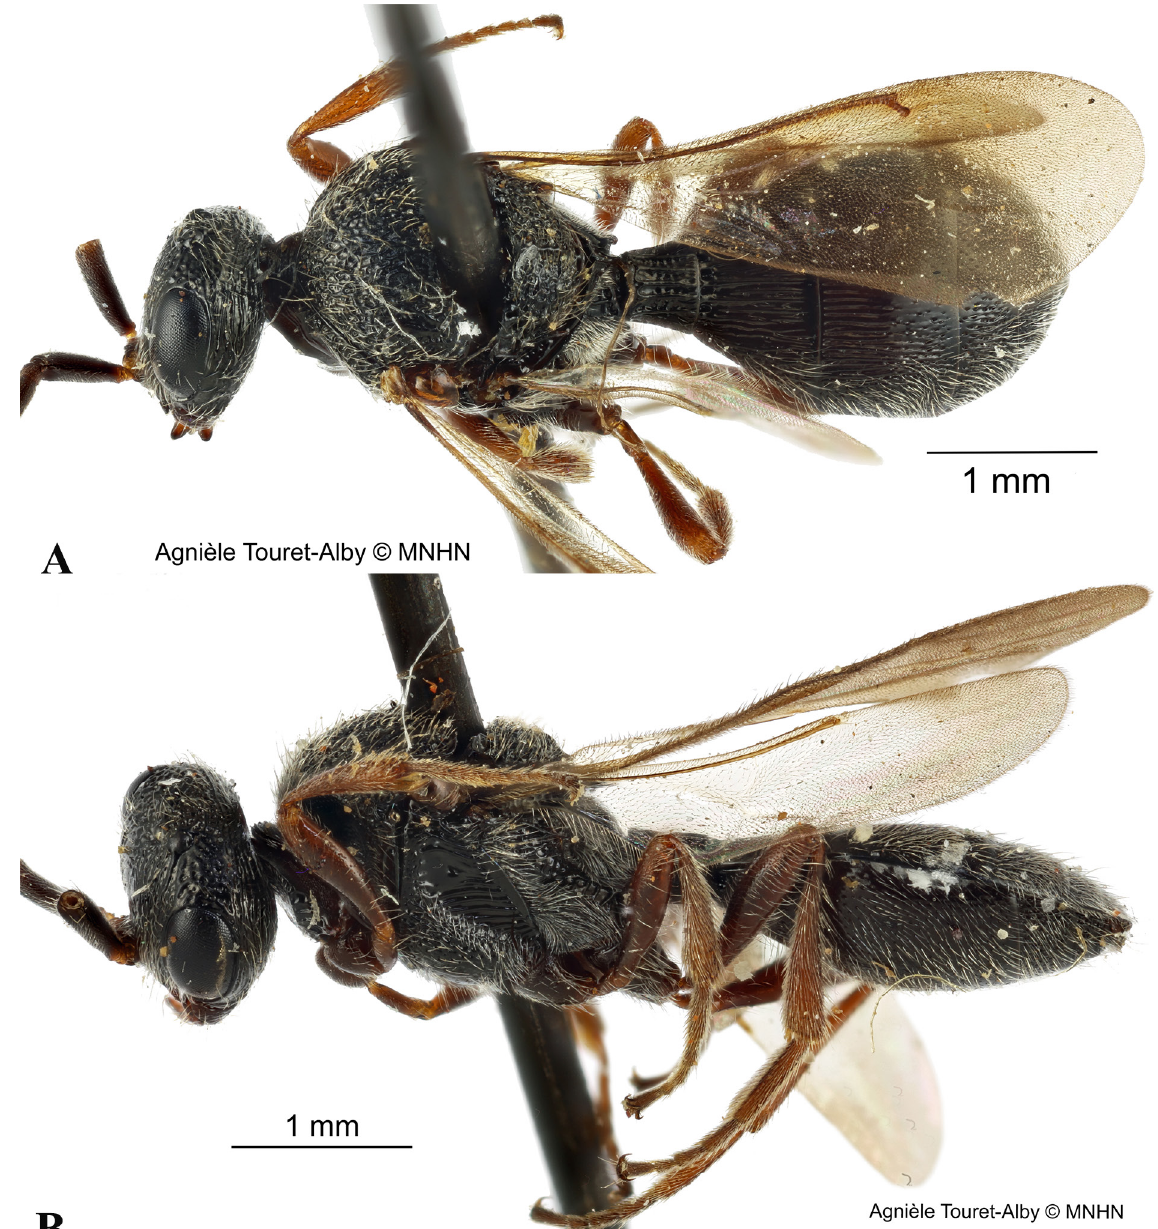
Fig. 7. Odontoscelio brevicephalus (Risbec, 1956). Syntype, ♂ (MNHN EY25669). A . Habitus (dorsal view). B . Habitus, (lateral view). Photos: Agnièle Touret-Alby © ,